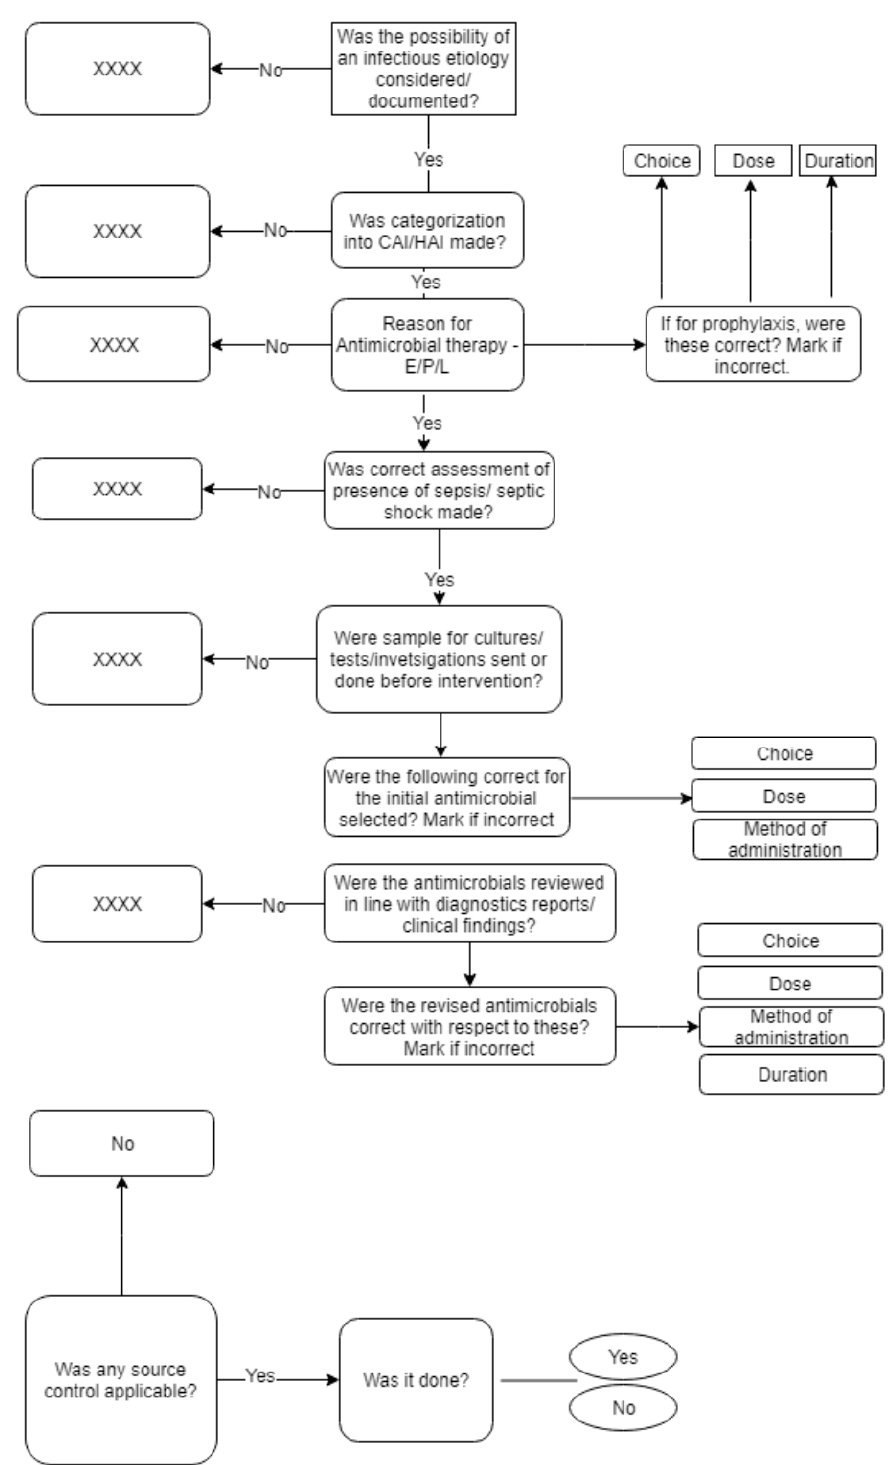
Figure 1. Antimicrobial Rationality Assessment Tool (AmRAT). CAI: Community-acquired infection; HAI: Hospital-acquired infection; E: Empiric; P: Prophylactic; L: Laboratory-based; XXXX—consider as irrational.